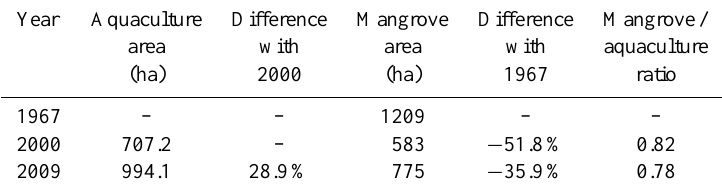
Table 2. Extent, difference and mangrove/aquaculture ratio of mangrove and aquaculture areas (1967–2000–2009) in ZMNNR, Gaoqiao, China.